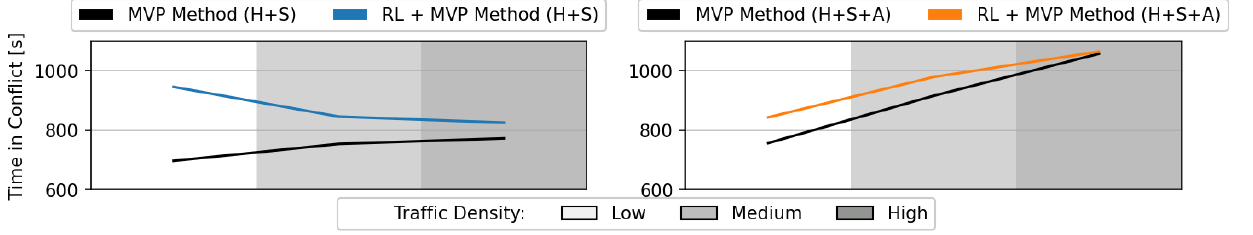
Figure 13. Time in conflict per aircraft during testing of the RL agent.